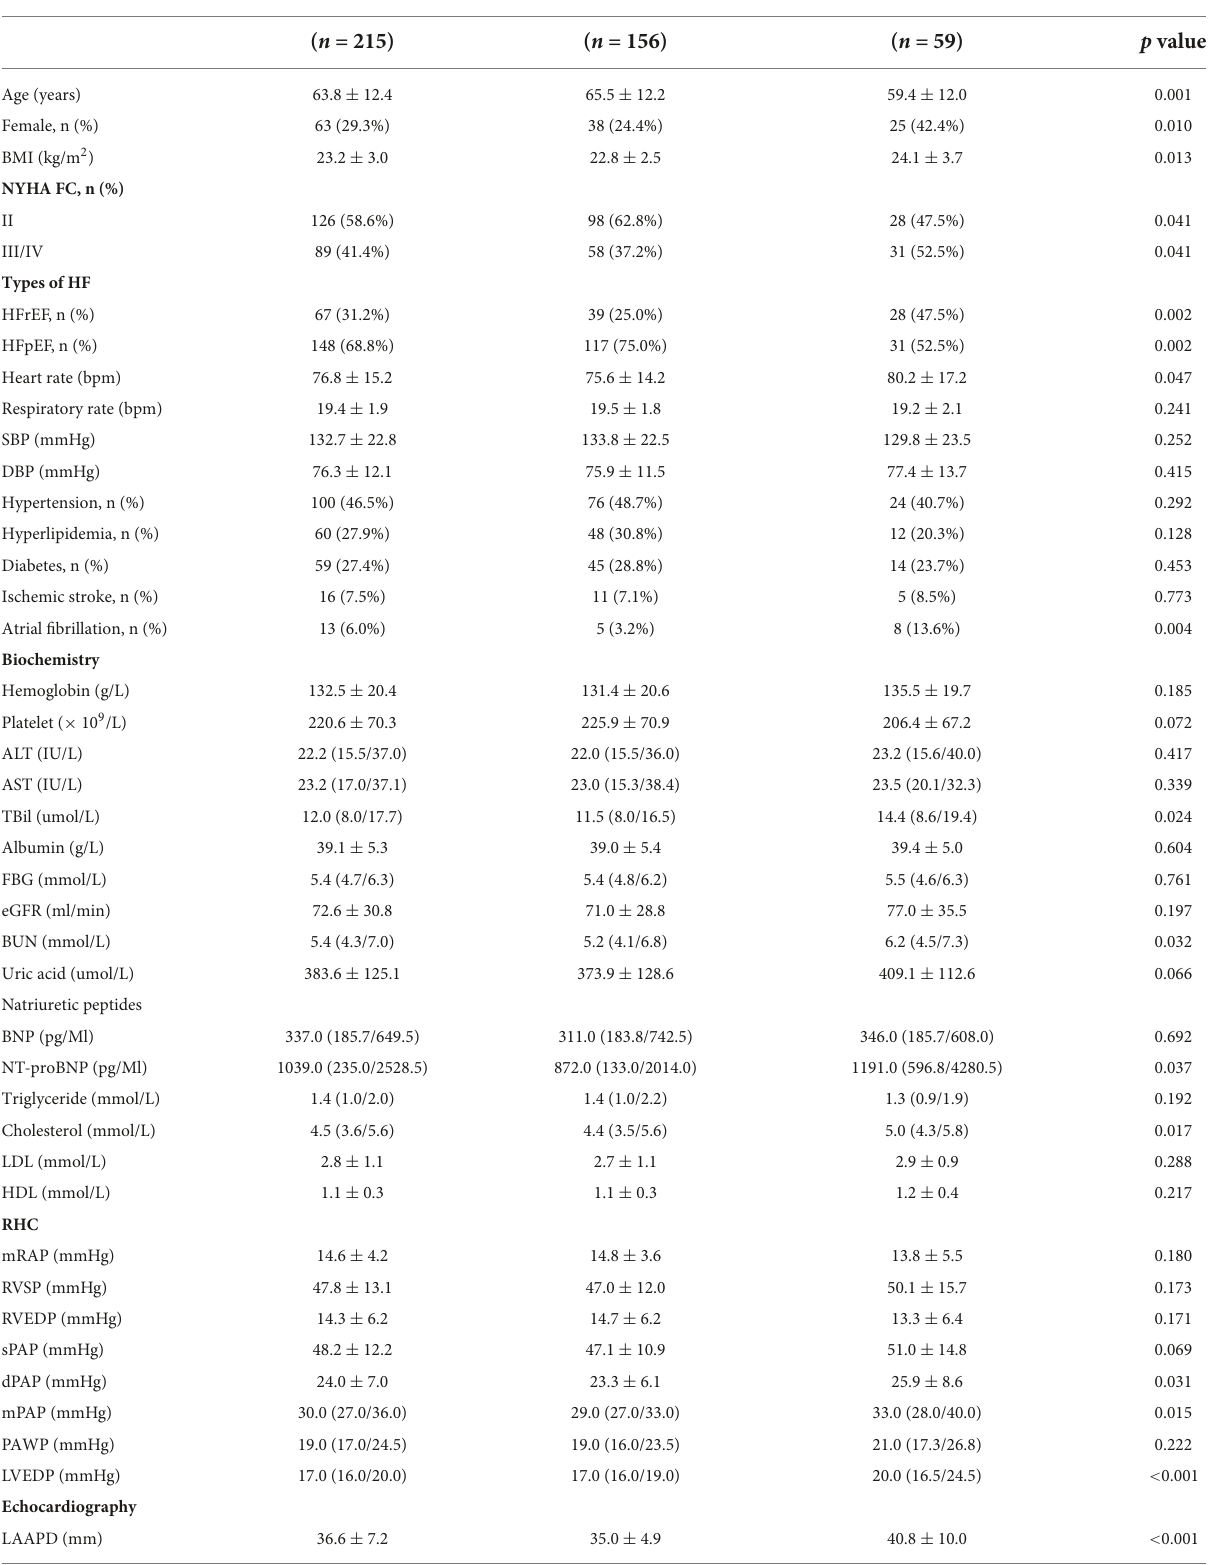
TABLE 2 Baseline demographic, clinical and hemodynamic characteristics of all patients with PH-LHF, patients with CAD and without CAD. Overall Patients with CAD Patients without